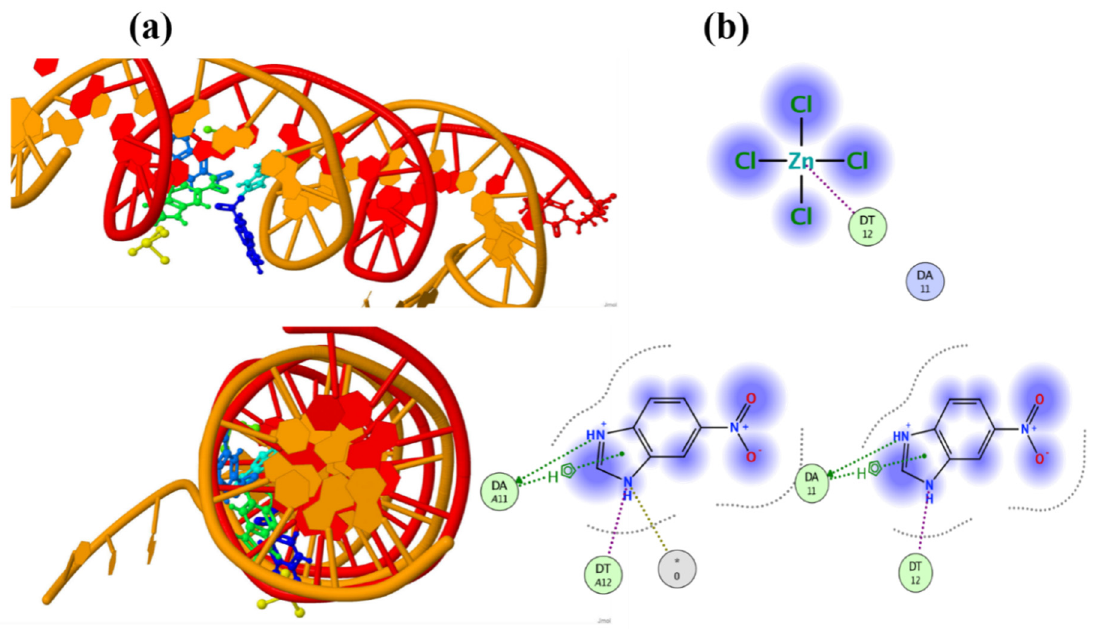
Figure 14. Side and lop view of molecular docked complex (C 7 H 6 N 3 O 2 ) 2 [ZnCl 4 ] ( a ) and its ligplots ( b ) determined by PM3 semi-empirical level of theory. Table 2. “Kb” and ∆ G values for the ds DNA complexes calculated from molecular docking data.